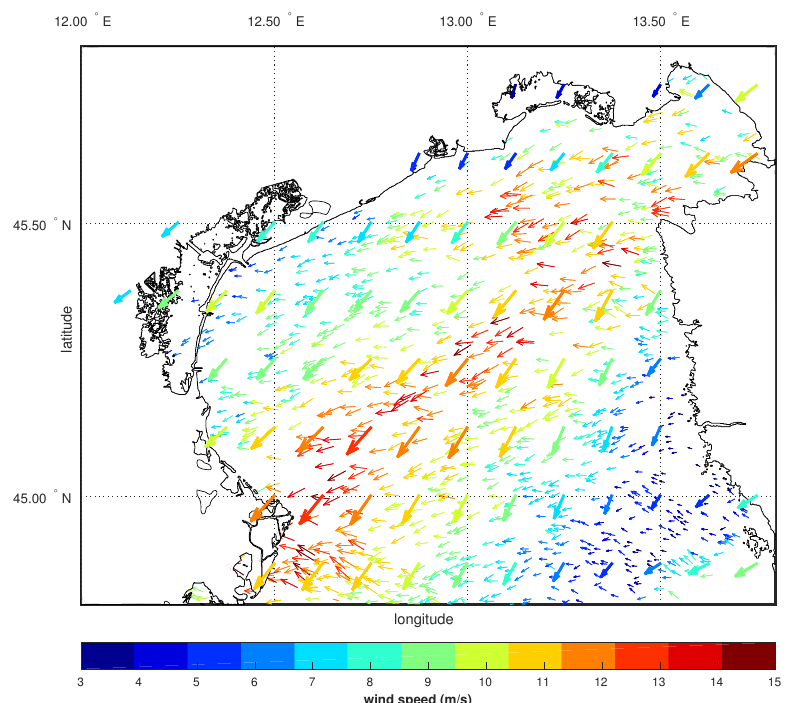
Figure 8. The SAR derived wind directions overlapped by those from ECMWF (bold arrows, not in scale) in the northern Adriatic Sea, 6 February 2017 4:58 p.m. GMT. The SAR wind directions have been obtained from the Sentinel-1A image S1A_IW_GRDH_1SDV_20170206T165804_20170206T165829_0151